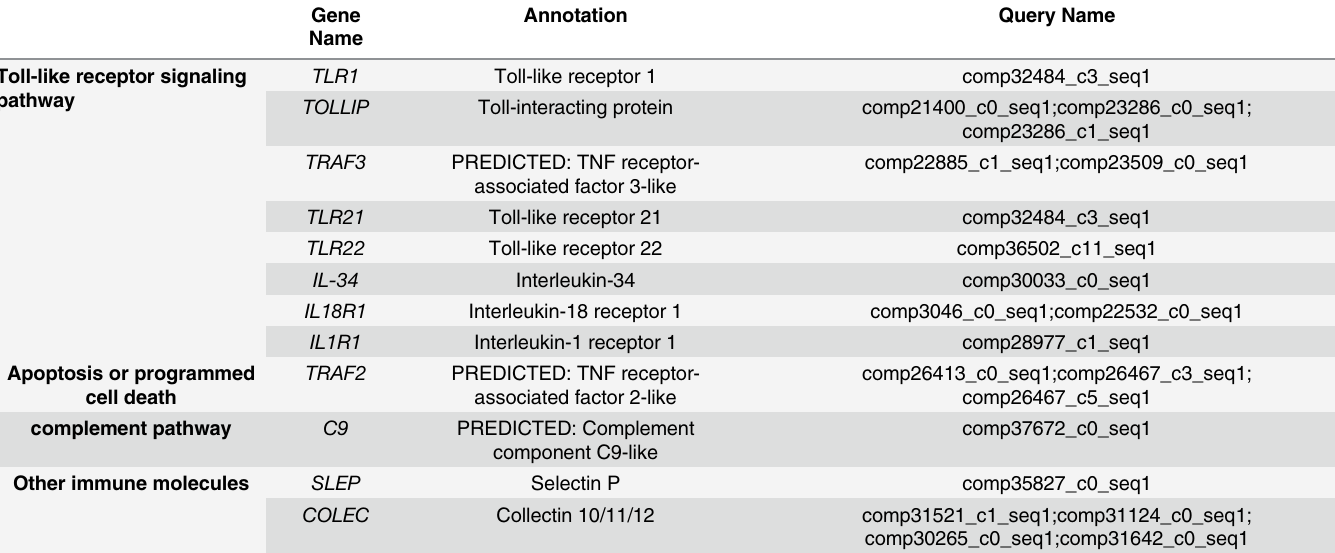
Table 4. The intriguing immune-related genes identified in the turbot